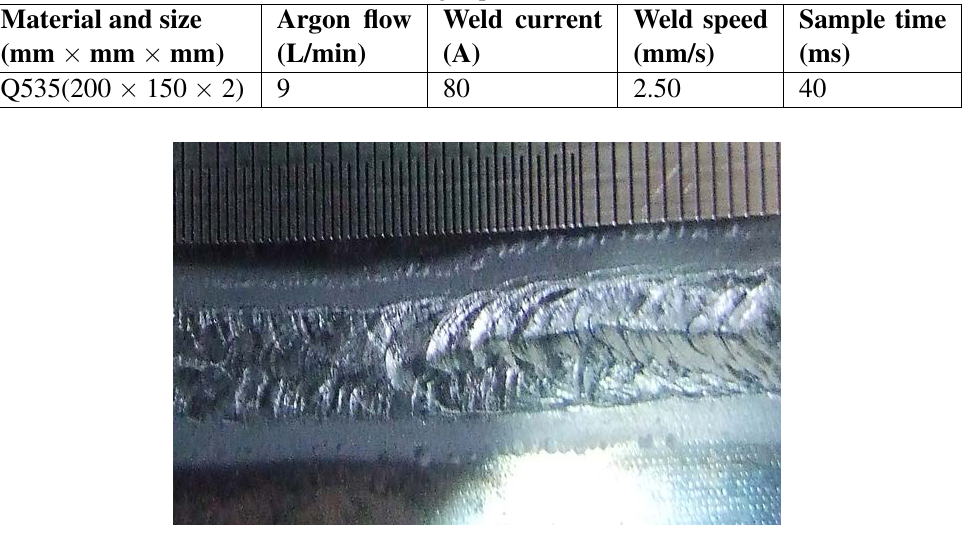
Fig. 7 Front side of welding seam